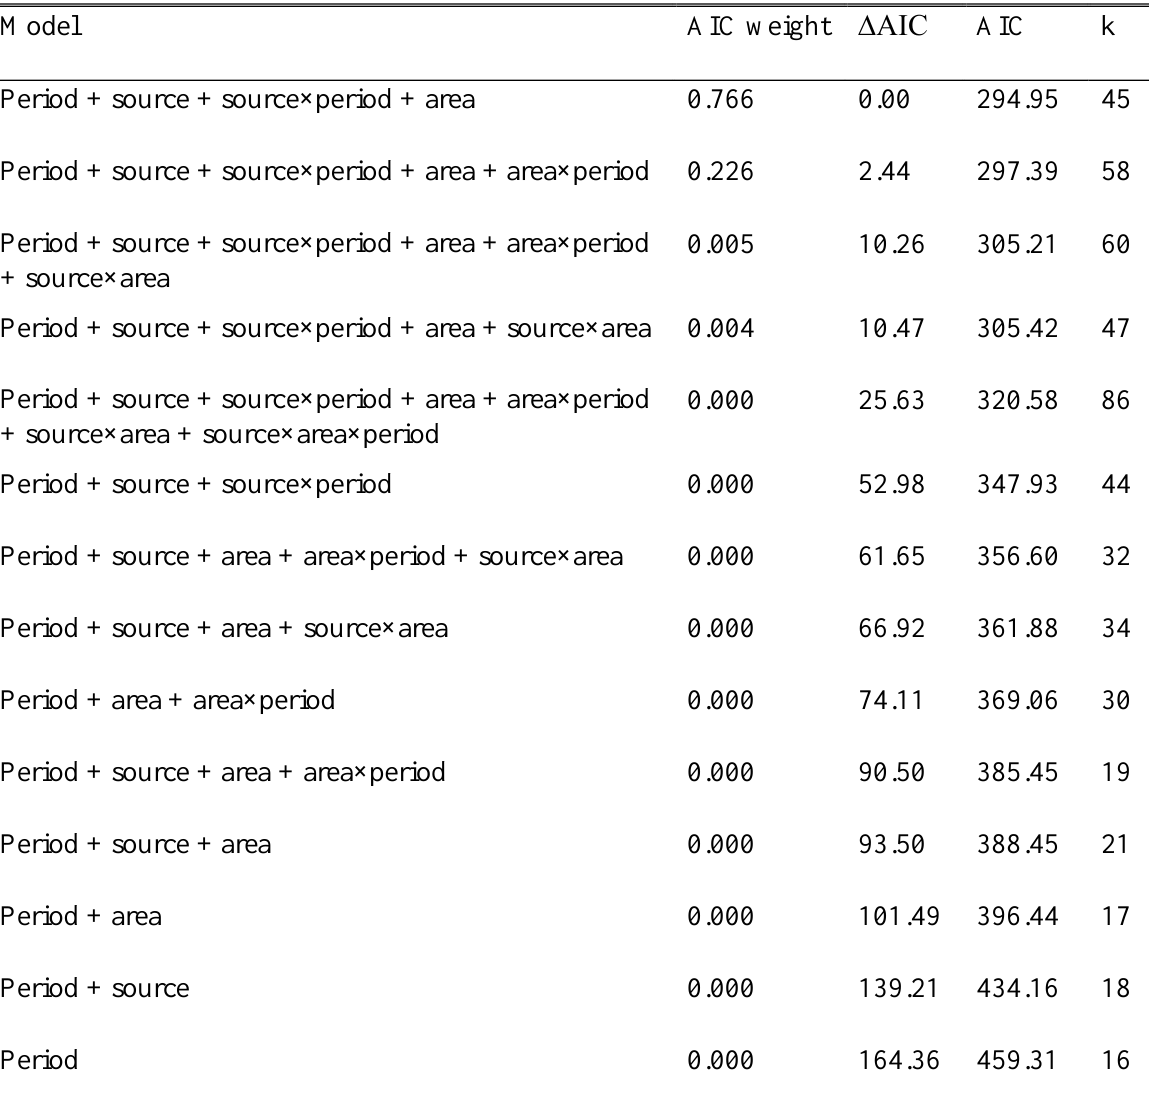
Table A1.1. AIC table for Tobit (censored 0–1) models of wetness of Sierra Nevada foothills wetlands, 2013–2016, with a random effect for site. Period is a factor representing 12 sampling time periods, source is a factor representing three water sources (natural-only, irrigation-only, both-source) and area was natural log of wetland size in